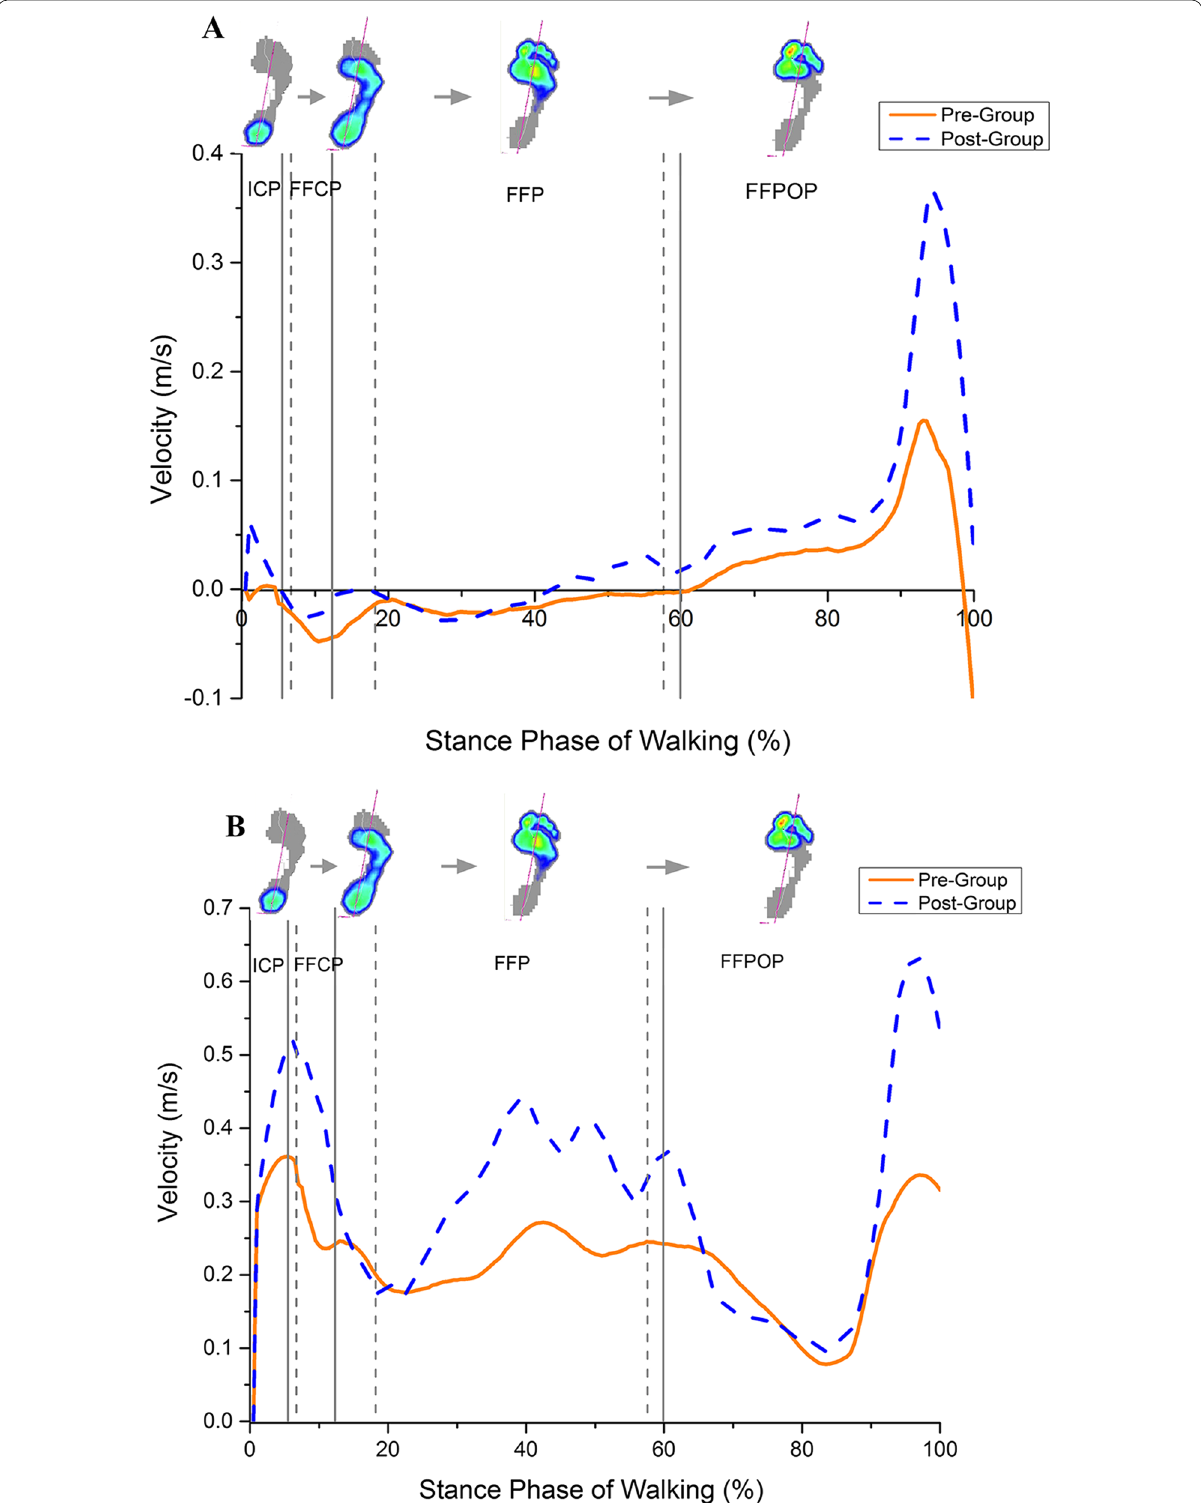
Fig. 3 The velocities of COP in ML- ( a ) and AP-direction ( b ) for the pre- and